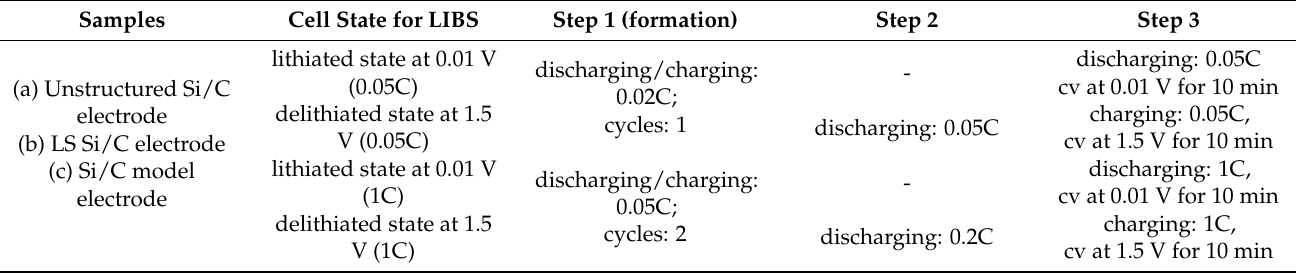
Table 3. Electrochemical testing procedures for the investigation of lithium concentration profiles.